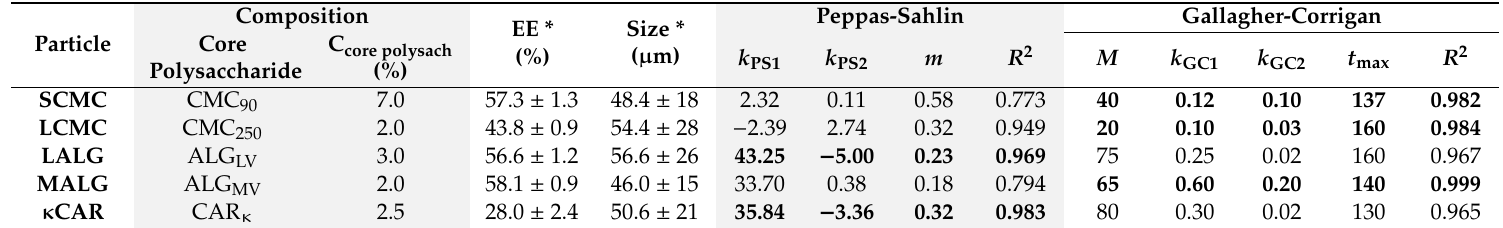
Table 1. Composition, characteristics, and kinetic parameters generated from mathematical models of the experimental data obtained from the in vitro release of the CE-loaded polysaccharide microparticles. Bold values indicate the best fit to the kinetic models. * The results are presented as the means ±